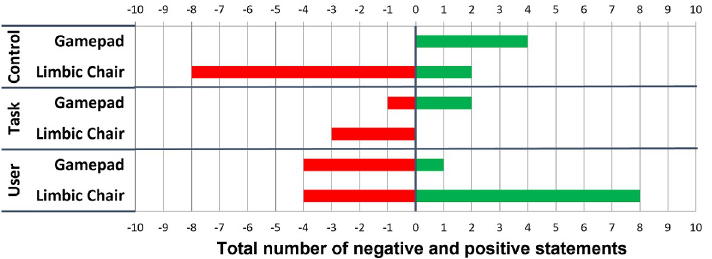
Fig 7. The results of the content analysis from Experiment 1. The total numbers of negative (red) and positive (green) statements are shown on the horizontal axis and encoded in three categories (Control, Task, and User) and for each control interface (vertical